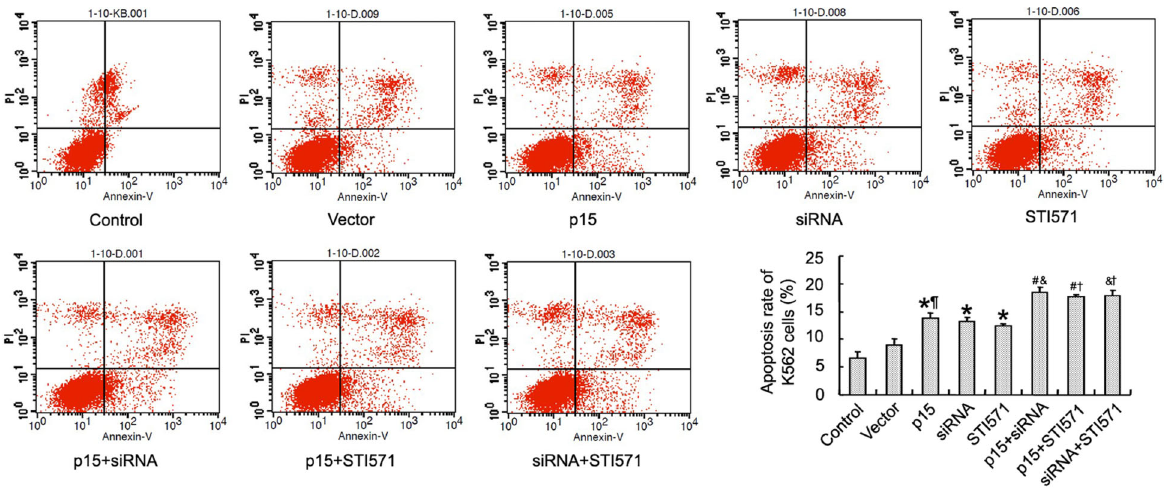
Figure 2. Effect of overexpressed p15INK4B alone or in combination with STI571 and BCR-ABL1 siRNA on the apoptosis of K562 cells. K562 cells were transiently transfected with p15INK4B, BCR-ABL1 siRNA or p15INK4B++BCR-ABL1 siRNA. After 24 h, the cells were plated onto 6-well plates at a density of 1 6 10 6 cells/well and incubated for another 24 h. Then, the cells were treated with STI571 (5 m mol/L) for 24 h and flow cytometry analysis was performed to determine the apoptosis of cells. Data are reported as means±SD from 3 independent experiments. *P , 0.01, compared with control; " P , 0.01, compared with vector group; # P , 0.01, compared with p15 group; & P , 0.01, compared with BCR-ABL1 siRNA group; { P , 0.01, compared with STI571 group (ANOVA followed by Fisher’s protected least significant difference test).